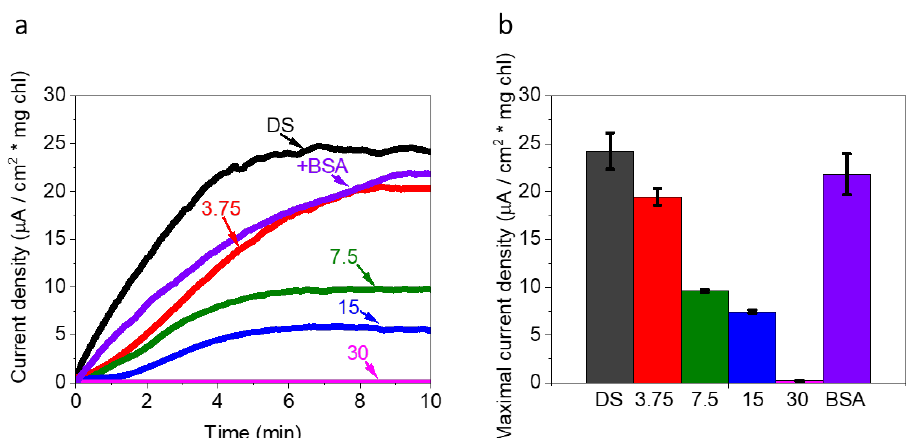
Figure 3. FNR eliminates the photocurrent production in DS-based BPEC. CA of DS was measured without or with increasing concentrations of FNR or with addition of BSA. The photocurrent production was decreased in proportion with the increasing FNR concentrations down to total elimination. ( a ) CA of Ds without the addition of FNR (black) and with the addition of 3.75 µM FNR (red), 7.5 µM FNR (green), 15 µM FNR (blue), 30 µM FNR (magenta) and 1 mg/mL BSA (violet). ( b ) Maximal current density over 10 min of CA. The error bars represent the standard deviation over three independent measurements.